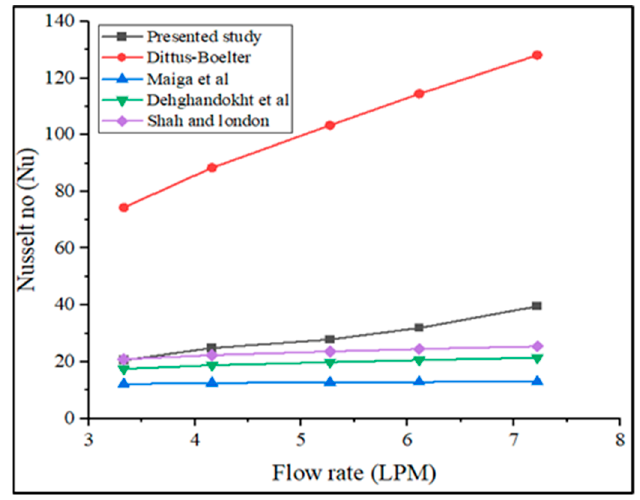
Figure 23. Comparison of Nusselt number of present studies with previous [51–53].